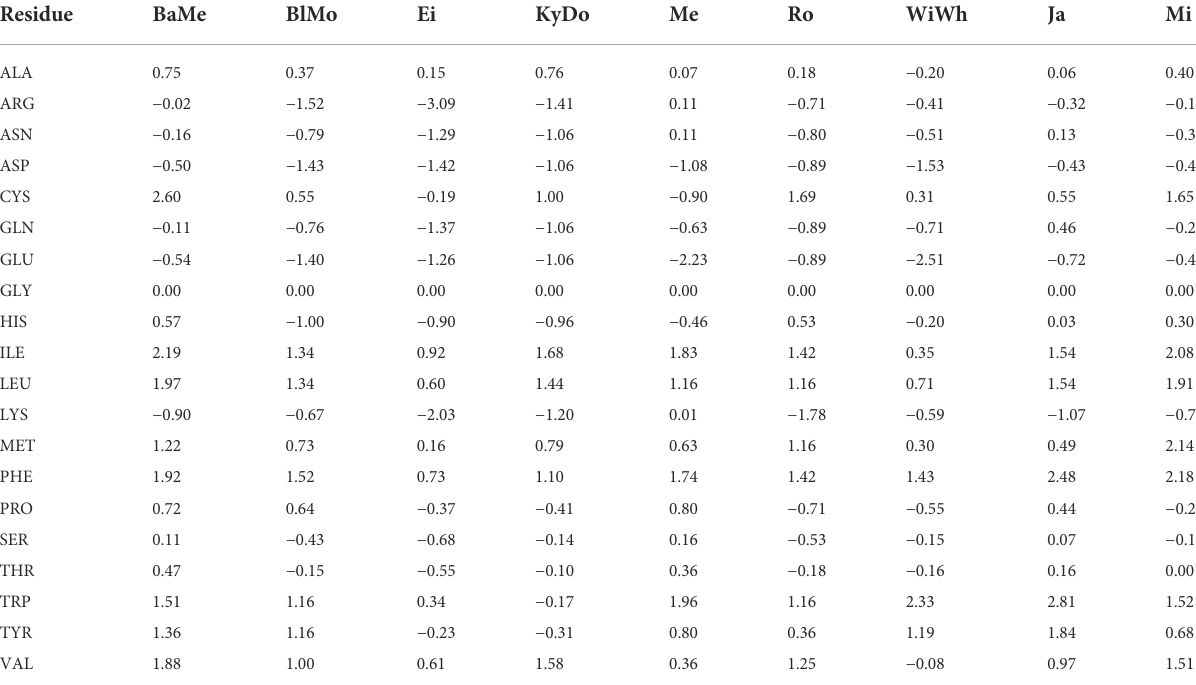
TABLE 2 The per-residue hydrophobicity scales that were used in this